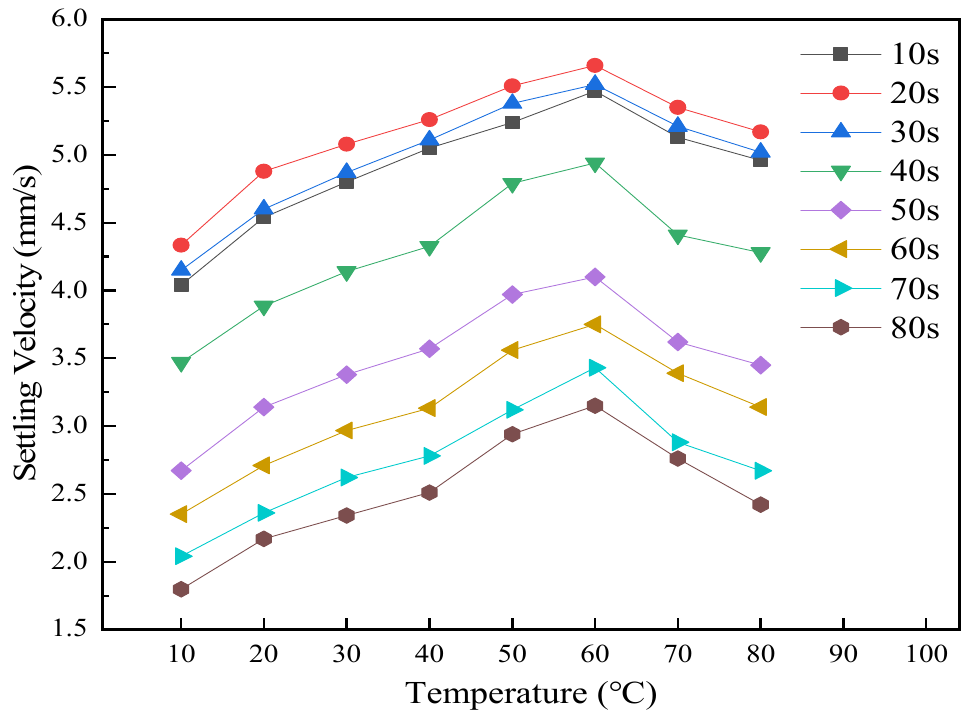
Figure 6. Relationship between tailings settling velocity and temperature at different times.